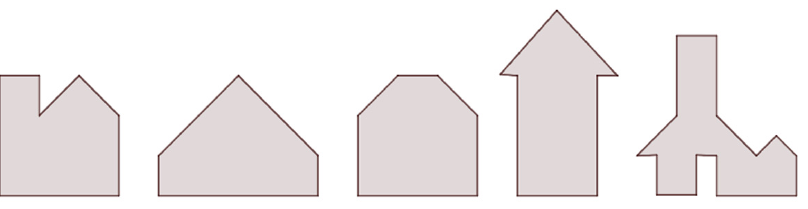
Figure 8. Assignment of Task 7.